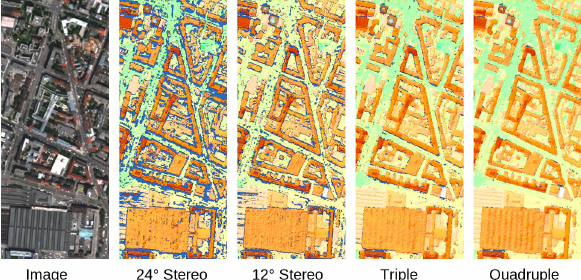
Figure 9: Comparison of DSMs generated in the area of the Mu- nich main station from WorldView-2 images using two images with 24 ◦ and 12 ◦ stereo-convergence-angle or three or all four images in parallel for the DSM generation. Using narrower con- vergence angles or more scenes reduce the occlusions (areas not visible in two or more images, shown in blue) drastically.